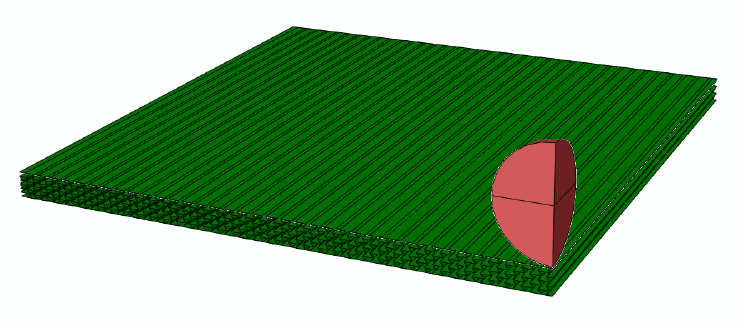
Figure 6. Low-velocity impact simulation in ABAQUS